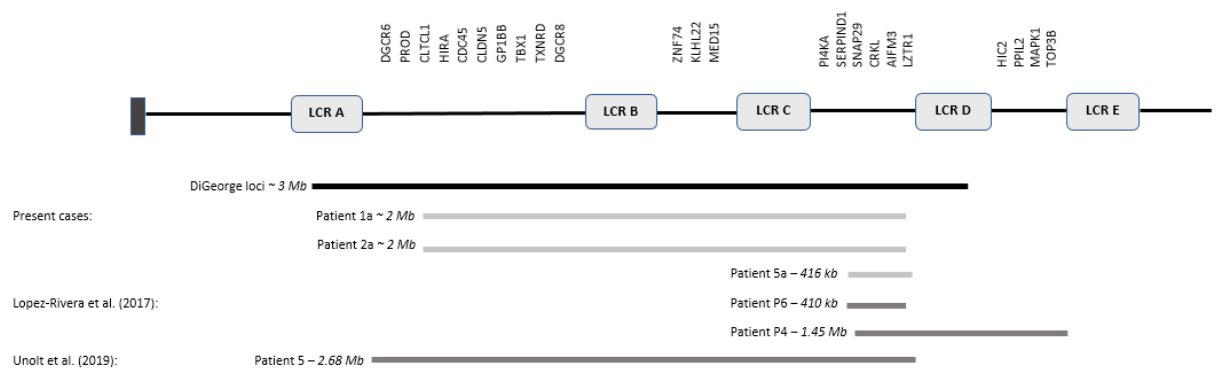
Fig. 2. The most common deletions in LCR region in DiGeorge syndrome, comparing our findings with